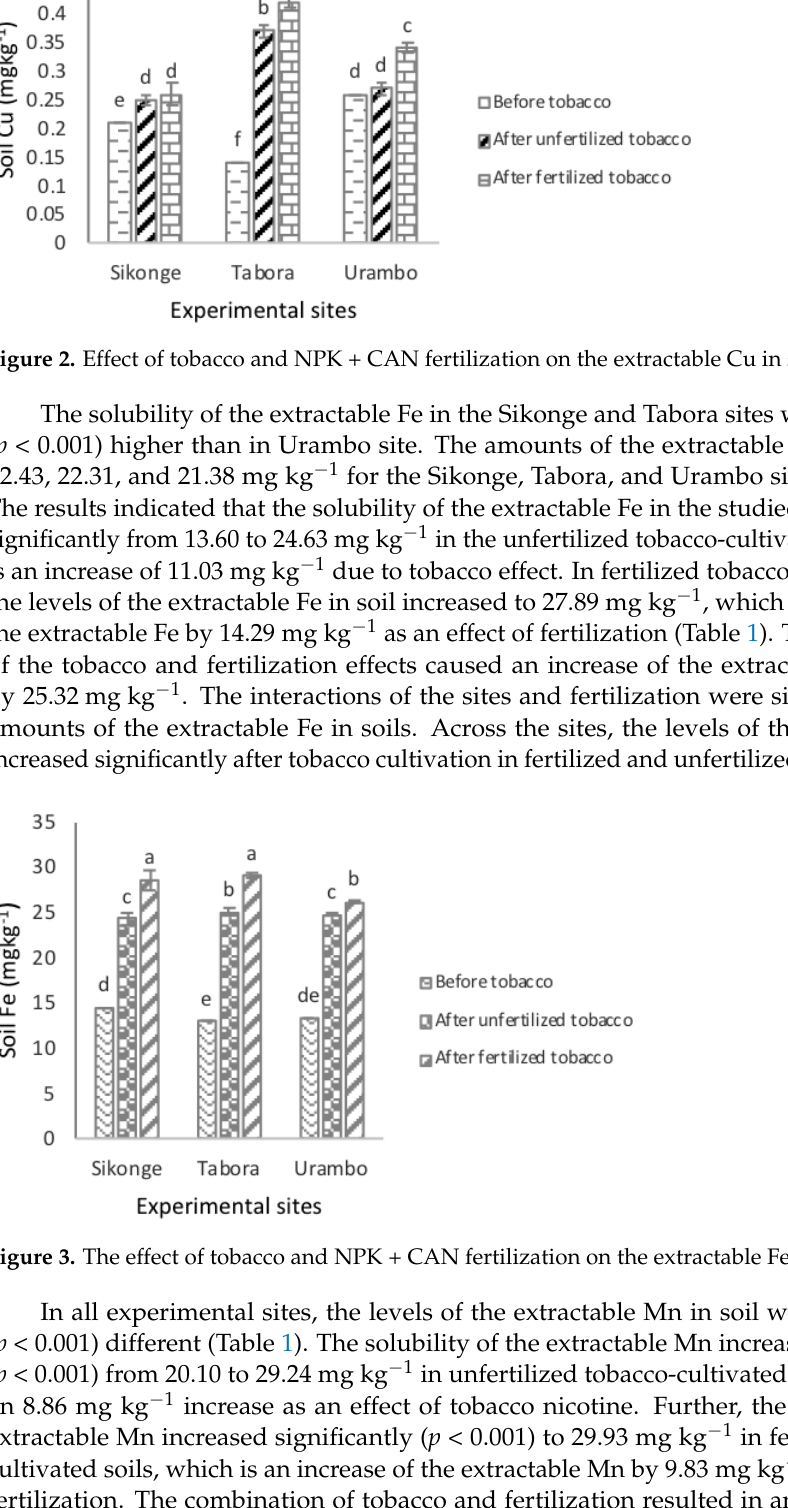
( p < 0.001) different (Table 1). The solubility of the extractable Mn increased significantly ( p < 0.001) from 20.10 to 29.24 mg kg − 1 in unfertilized tobacco-cultivated soils,